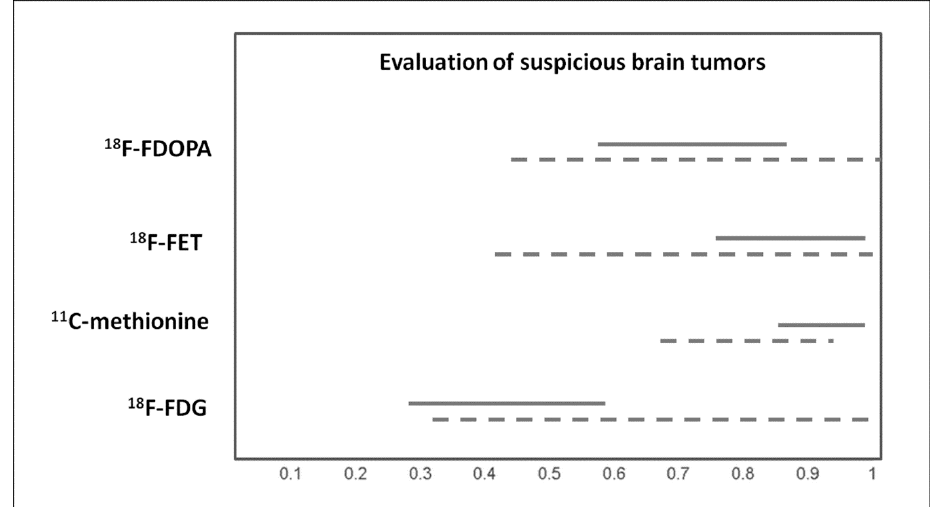
Figure 2. Graph showing 95% confidence intervals of sensitivity (continuous line) and specificity (dashed line) of PET with different tracers in evaluating suspicious brain tumors, according to published meta-analyses.